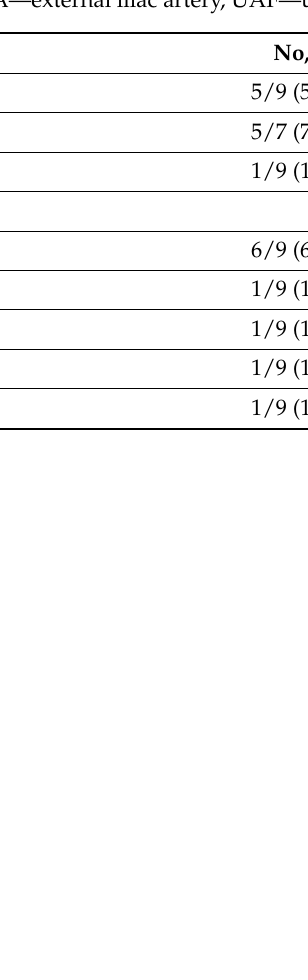
Figure 2. Arteriographic aspect after stent graft stenting of left CIA.